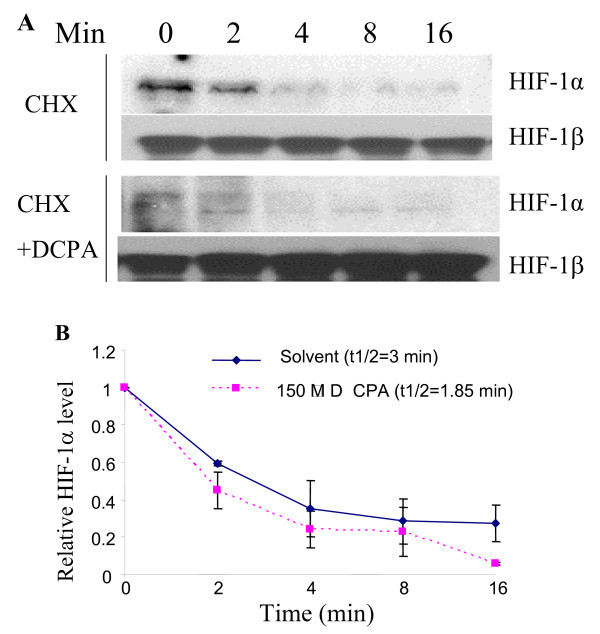
Effect of DCPA on HIF-1α protein stability. A. PC-3 cells were cultured in serum-free medium for 24 h, followed by the incubation with 10% fetal bovine serum for 5 h. Then the cells were treated with solvent alone (CHX, top panel) or 150 μM DCPA (CHX+DCPA, bottom panel) for 1 h, followed by the incubation with 100 μM cycloheximide for 0 to 16 min. Cellular lysates were subjected to immunoblotting using antibodies against HIF-1α and HIF-1β. B. The intensity of HIF-1α protein signals obtained above was quantified from three replicate experiments using EagleSight densitometry software (Version 3.21; Stratagene). The densitometry data were the ratio of HIF-1α/HIF-1β, and normalized to that of the control (0 min).